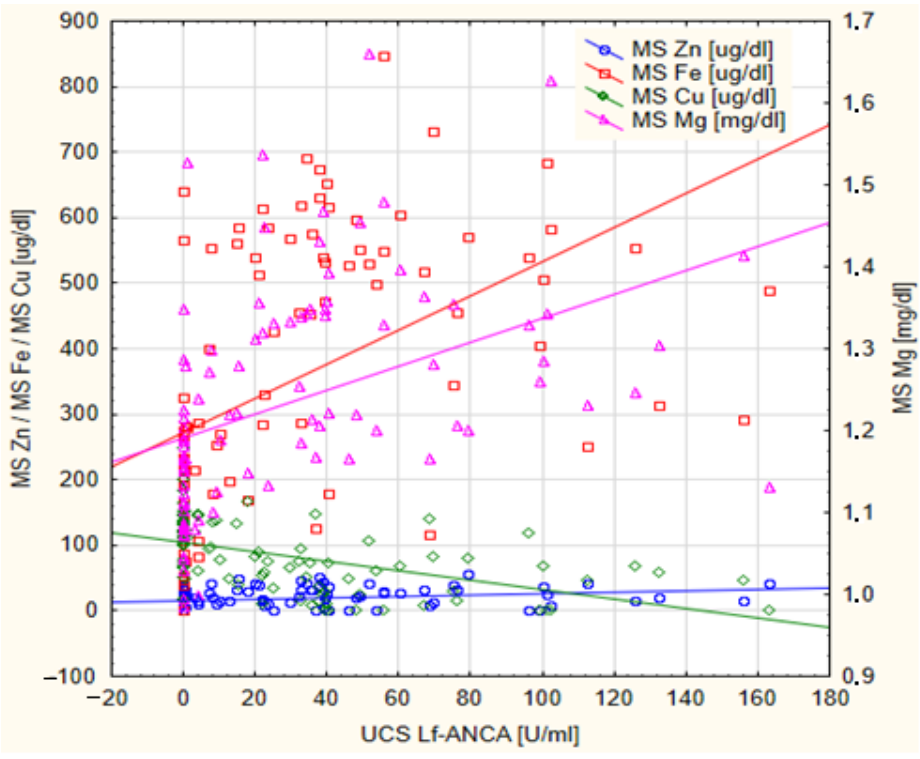
Figure 2. The scatterplot of the concentrations of antineutrophil cytoplasmatic auto-antibodies against lactoferrin in the umbilical cord serum (UCS Lf-ANCA) of newborns in relation to the concentration of iron (MS Fe), copper (MS Cu), zinc (MS Zn) and magnesium (MS Mg) in maternal